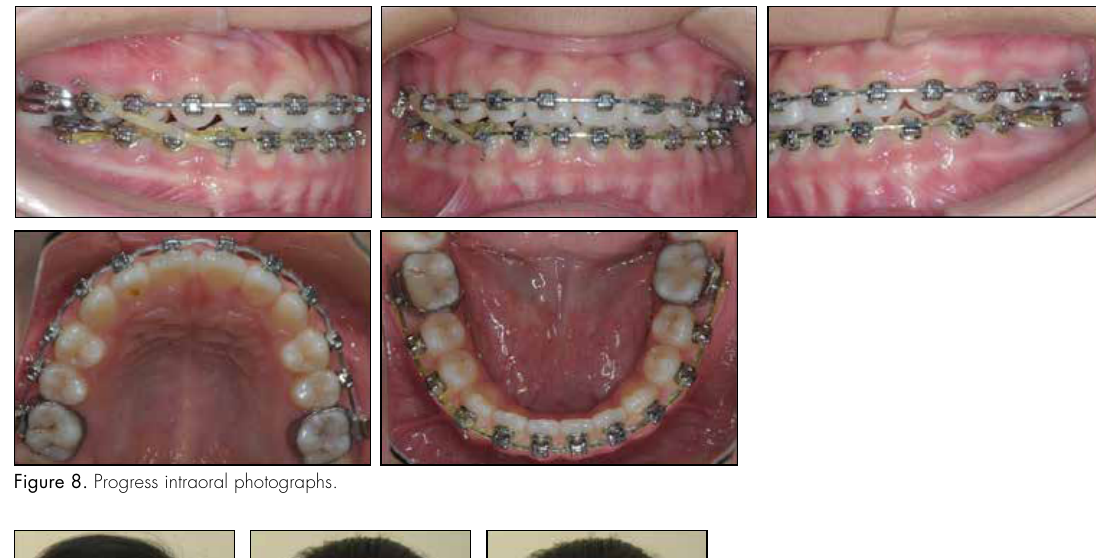
Figure 8. Progress intraoral photographs.